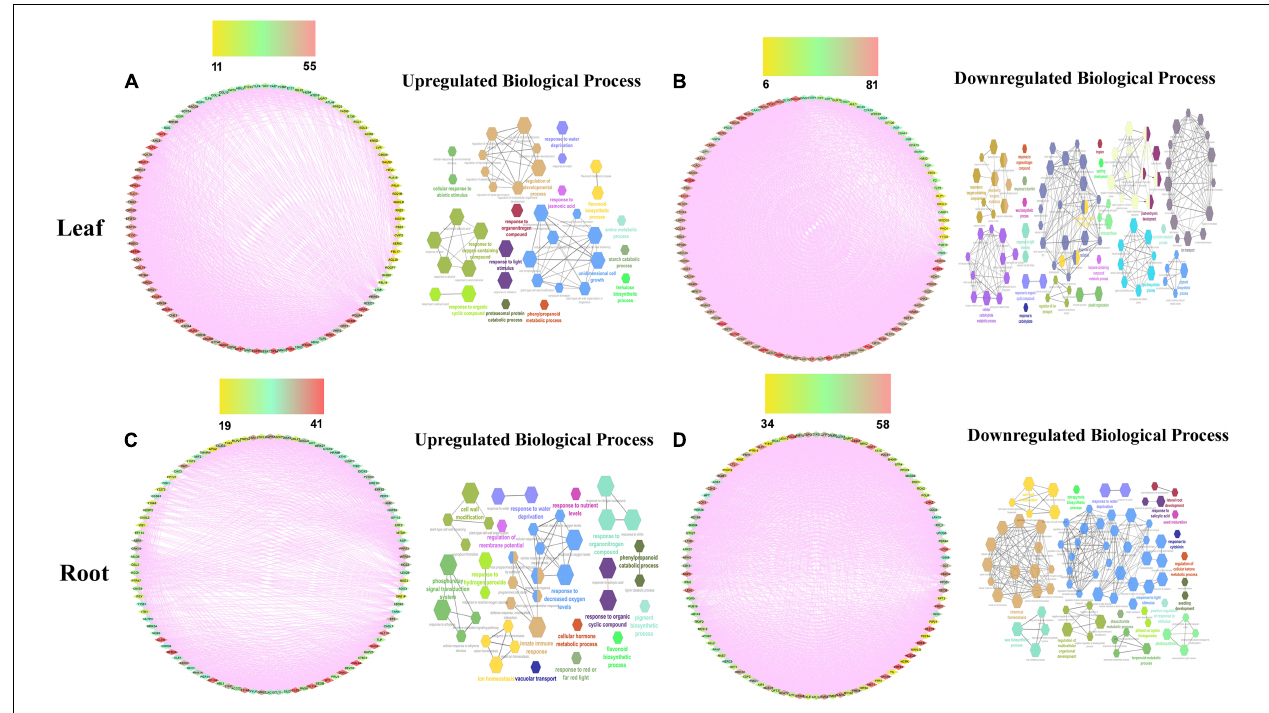
FIGURE 2 | The drought-responsive gene network analysis of the top 100 upregulated (A,C) genes with their biological processes (B,D) in leaf and root tissues. Scales are showing from lower to higher degree